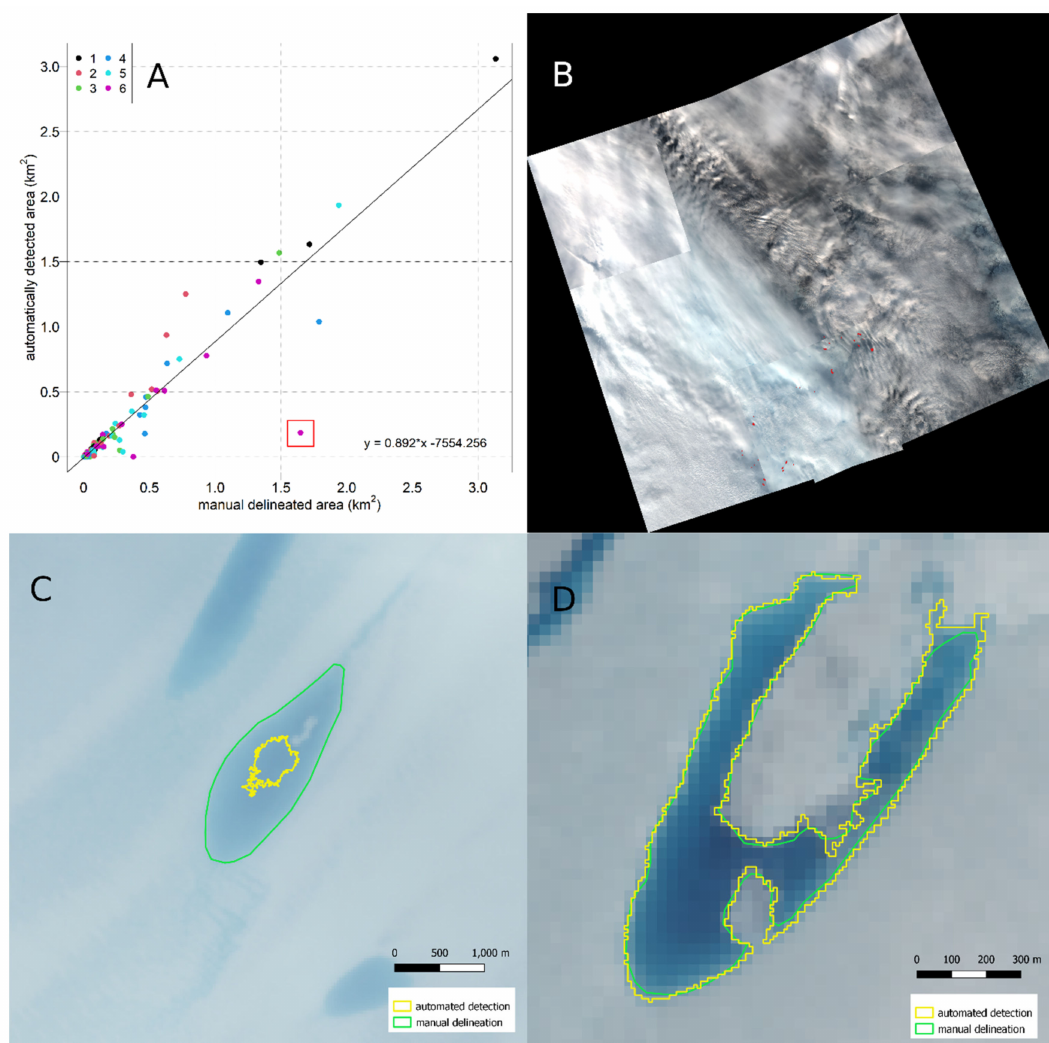
Figure 11. Comparison of automatically detected and manually digitized lakes. ( A ) Linear regression (solid line) of manually ( x -axis) and automatically ( y -axis) derived lake areas. Point colors display cloud classes. Red rectangle: outlier lake (sink number 1020 of 1035) of date 17 August 2019. ( B ) RGB composite of date 17 August 2019, classified as extremely cloudy (class 6). ( C ) RGB closeup of the outlier (lake 1020, 30 m resolution) on the same date, with manually delineated extent (green) and automatically detected extent (yellow). ( D ) Difference between pixel-based (yellow) versus manual (green) delineation for lake 684, date 29 July